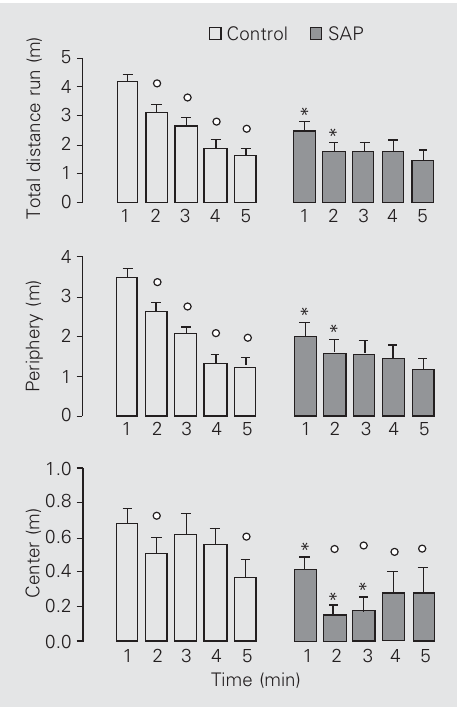
2. Effect of intraseptal le- sion of the cholinergic